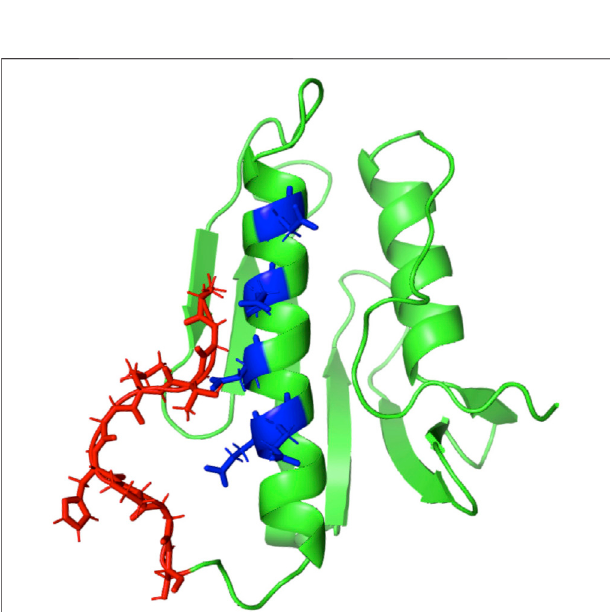
FIGURE 13 | We display the con fi guration of the 81-90 disordered region in red as it results after an elaborated MD relaxation step that was started from an all-trans geometry. The potential metal-binding site locations are highlighted in